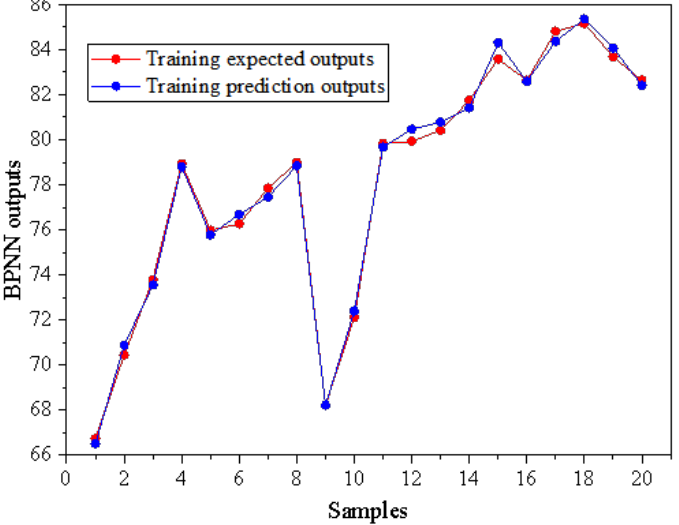
Figure 12. Mean squared error in the process of the BP neural network training.